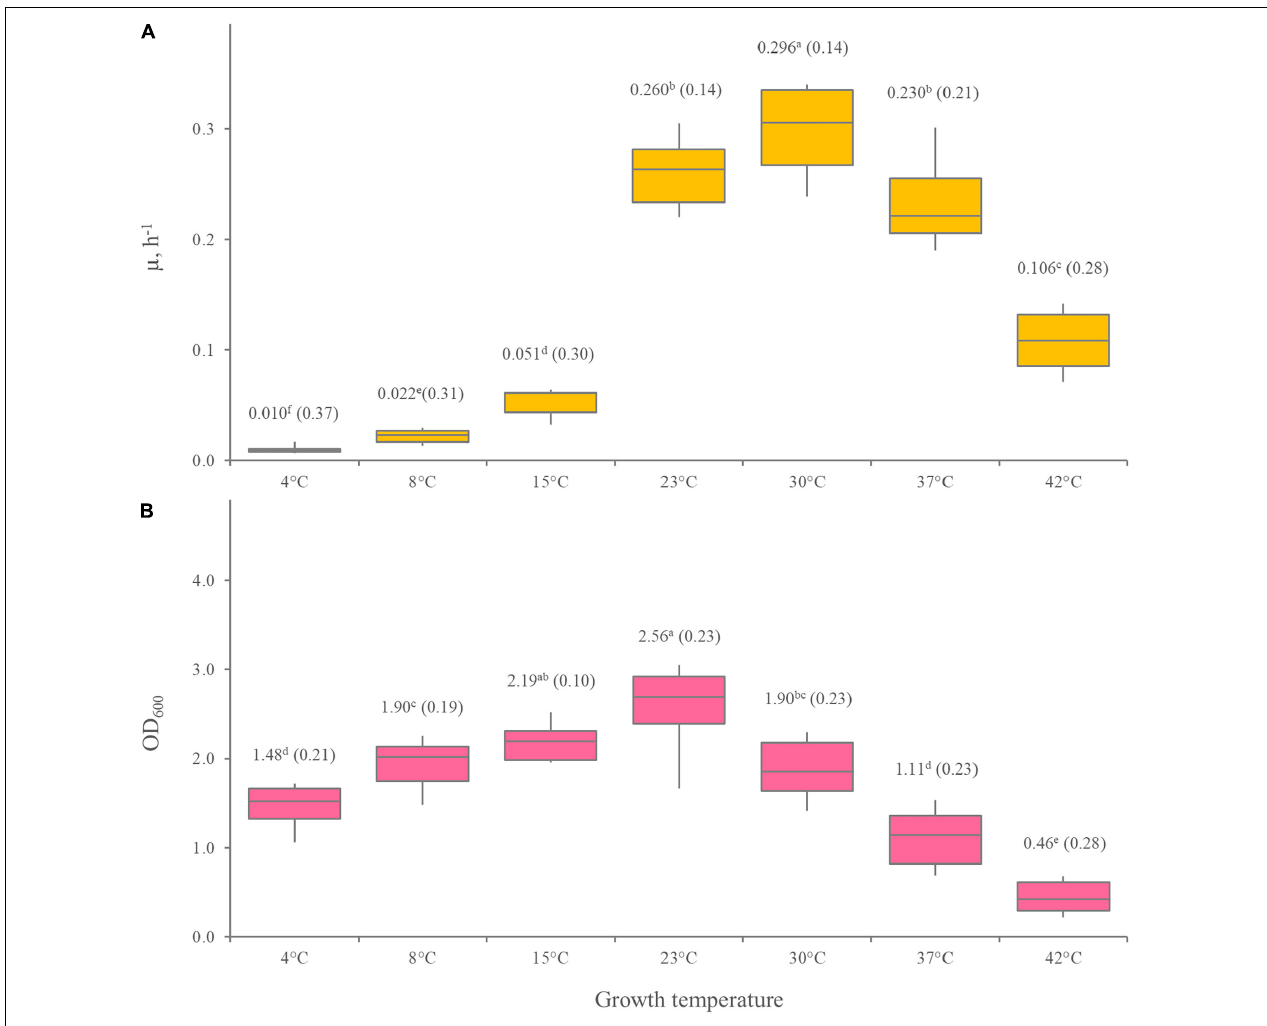
FIGURE 2 | Effect of temperature on µ max (A) and the biomass yield (B) of 12 Leuconostoc carnosum strains, cultured in MRS broth for 48 h. (B) Boxes indicate the 25th, 50th, and 75th percentiles; whiskers indicate the 10th and 90th percentiles. Mean values are reported in the labels, with the coefficient of variation in brackets. Within each panel, means with different letters significantly differ ( p < 0.05, ANOVA with Tukey’s post hoc